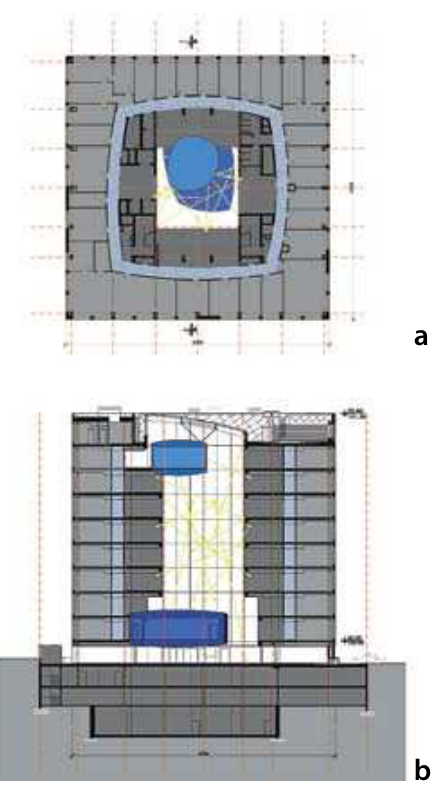
Fig. 12. Prosecutor's Office building: typical floor plan Fig. 13. Prosecutor's Office atrium,